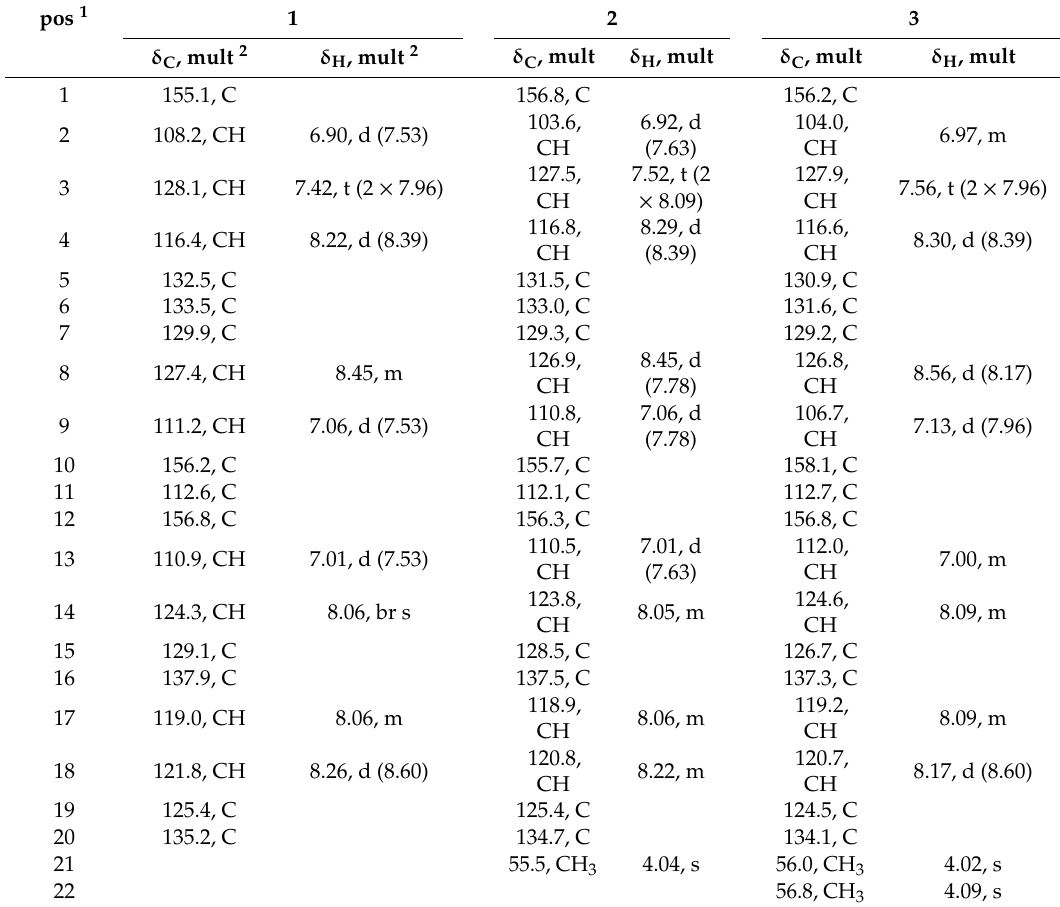
/ δ C H : chemical shift [ppm]; mult: multiplicity, (br) s: (broad) singlet, d: